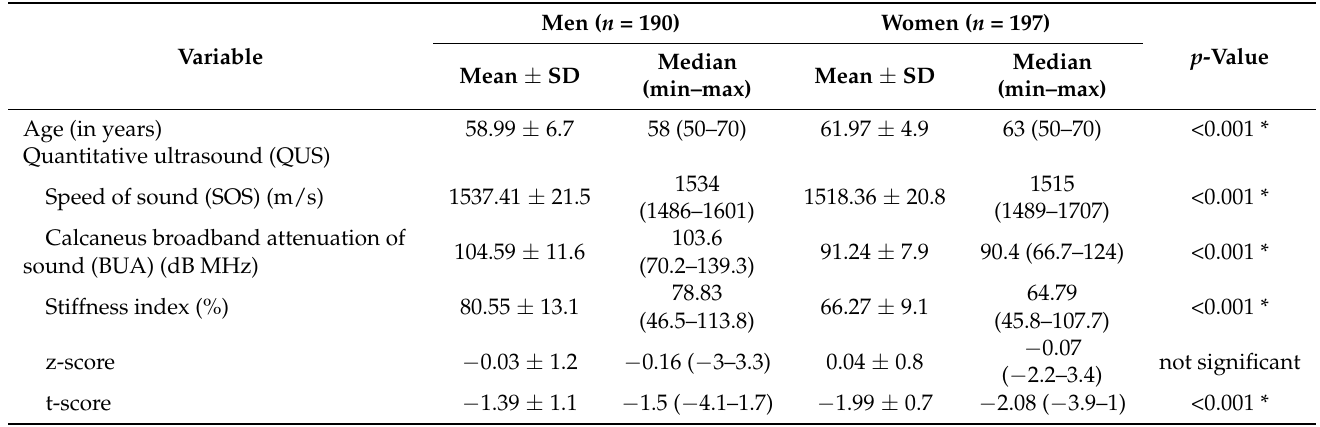
Table 1. Demographic data of the 387